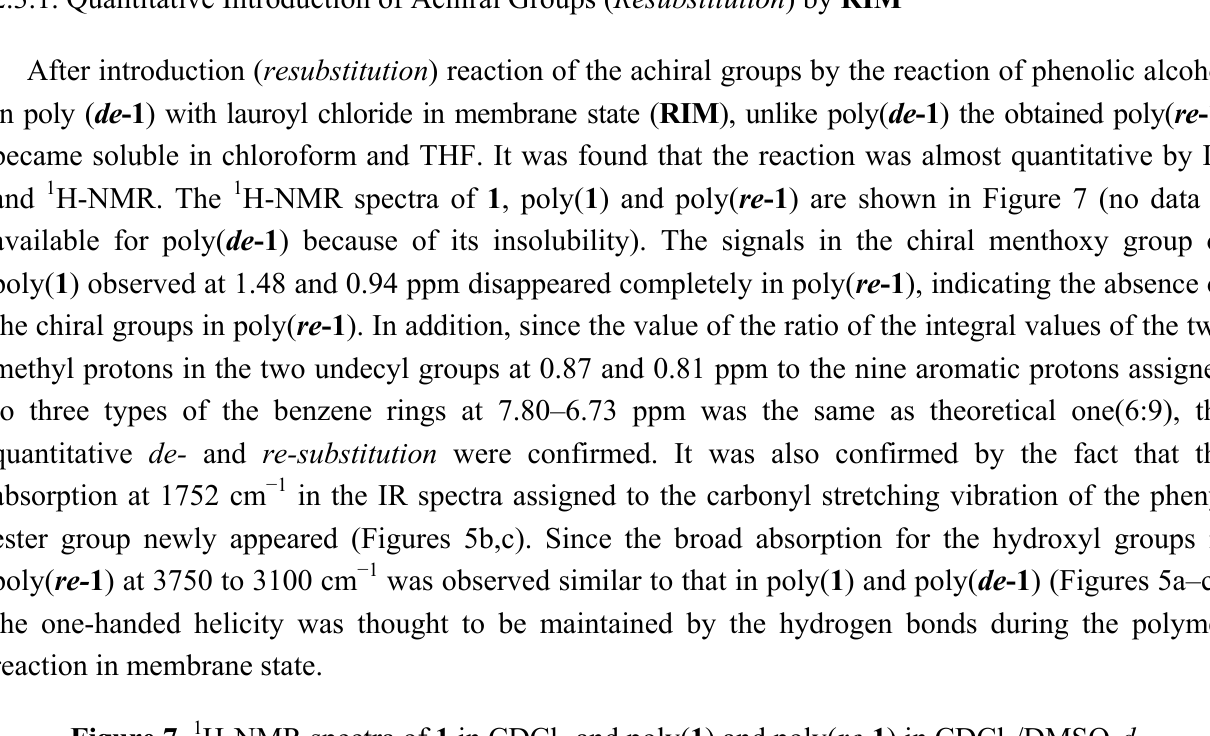
Figure 7. 1 H-NMR spectra of 1 in CDCl